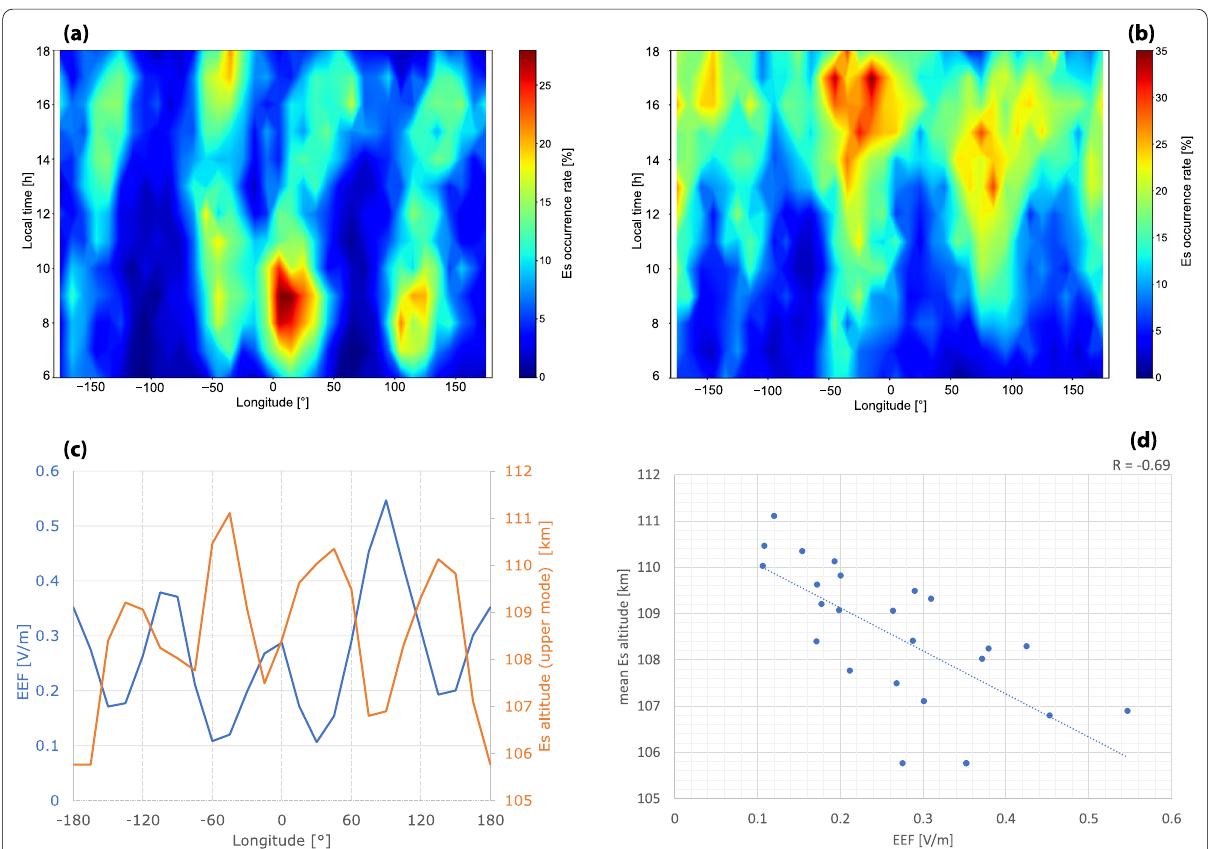
Fig. 11 a The plot shows the equatorial Es OR during autumn in a longitude–local time cross-section. For this plot, we considered Es events from the upper mode (altitude > 105 km). Image b : same as plot a but for Es layers appearing below 105 km. c Comparison of longitudinal variability of eastward EEF (blue) and the upper mode of equatorial sporadic E layers (orange). A clear anticorrelation (R observed and manifested in the lower right plot d where the Es altitude is mapped against the